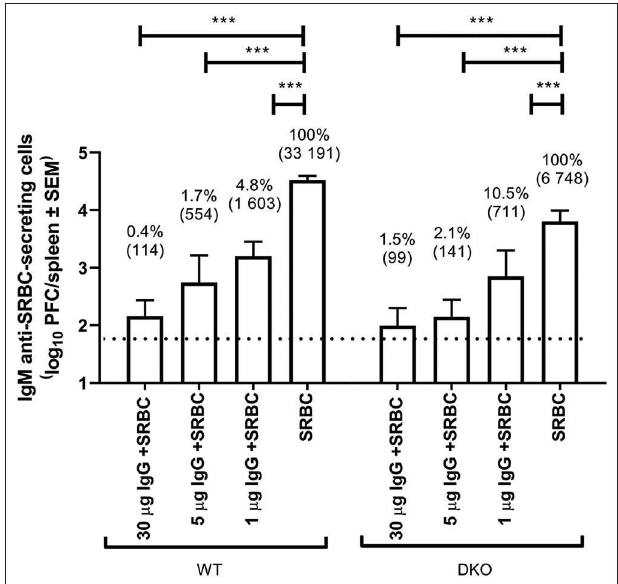
FIGURE 1 | IgG suppresses IgM anti-SRBC responses in (FcR γ × C3) DKO mice. WT or (FcR γ × C3) DKO mice ( n = 3–7/group) were immunized i.v.